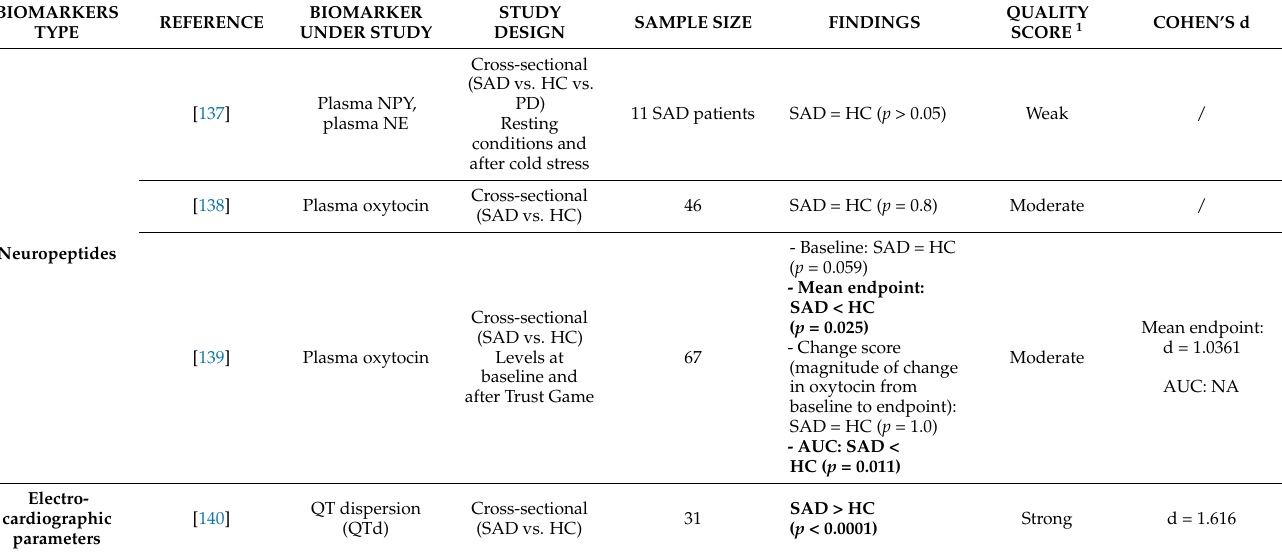
Table 8. Summary of findings regarding neuropeptides and electrocardiographic biomarkers of